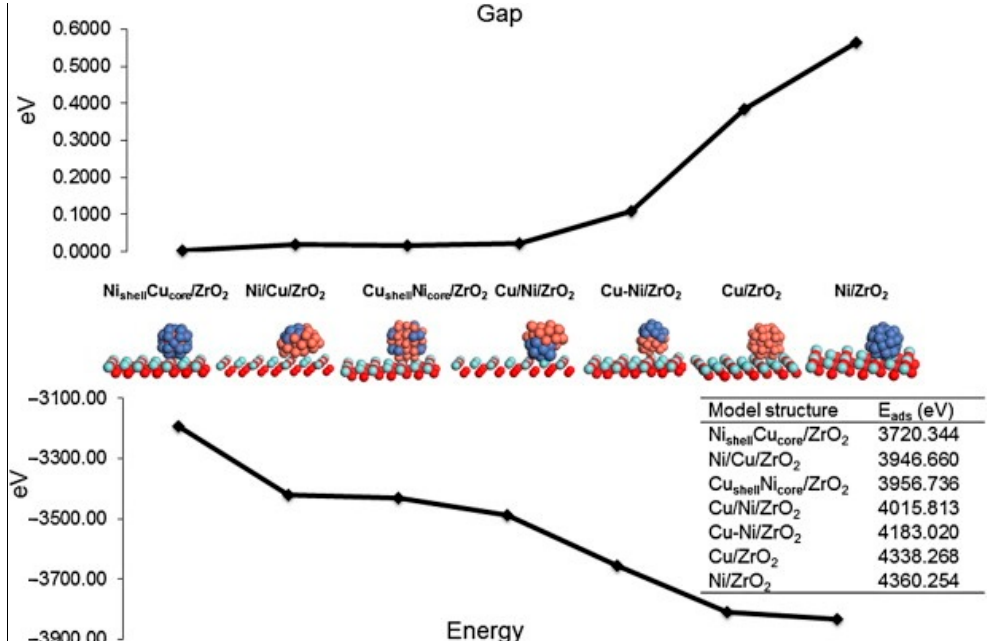
Figure 5. Molecular models of bimetallic and monometallic clusters: the top graph shows the gap- energy, the bottom graph shows the system total energy and the inset shows the adsorption energy of methanol on the surface. Reprinted with permission from Ref. [74]. Copyright 2022 Elsevier.